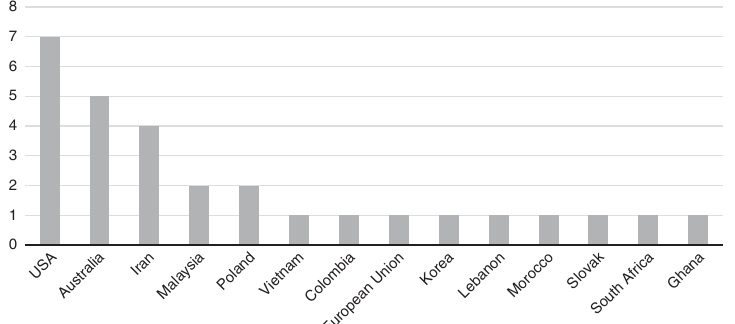
Figure 2. Research